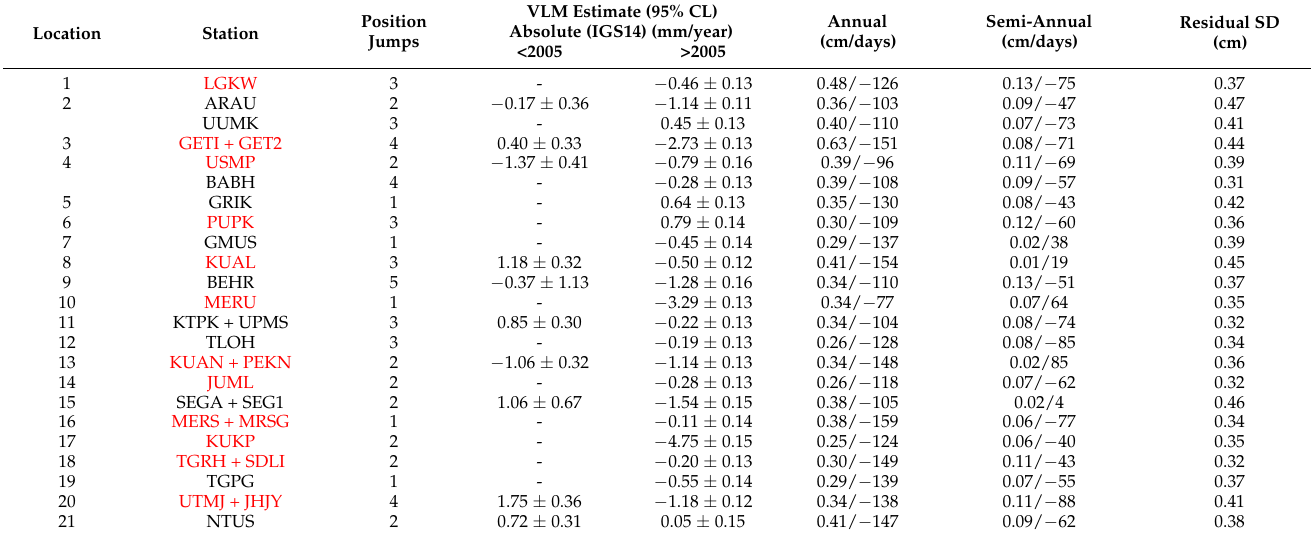
Table 6. VLM trend estimates at 21 locations in Peninsular Malaysia and Singapore (1994–2021). At 10 locations, split trend estimates distinguish between the inter-seismic period until 25 December 2004 (<2005) and the post-seismic period (>2005, linear trend estimate from 2011 onwards) from 26 December 2004 onwards due to the 2004 Mw 9.2 Sumatra–Andaman earthquake. The red font indicates that the station is located nearby a Malaysian tide gauge and combined MASS/MyRTKNet stations are given as MASS + MRTK. The linear trend estimates are given at a 95% confidence level (1.96 sigma). The number of estimated (vertical) position jumps for each station is given, and also the amplitude and phase of the annual and semi-annual signals. The residual sigma is the SD of the difference between the data and the model fit.